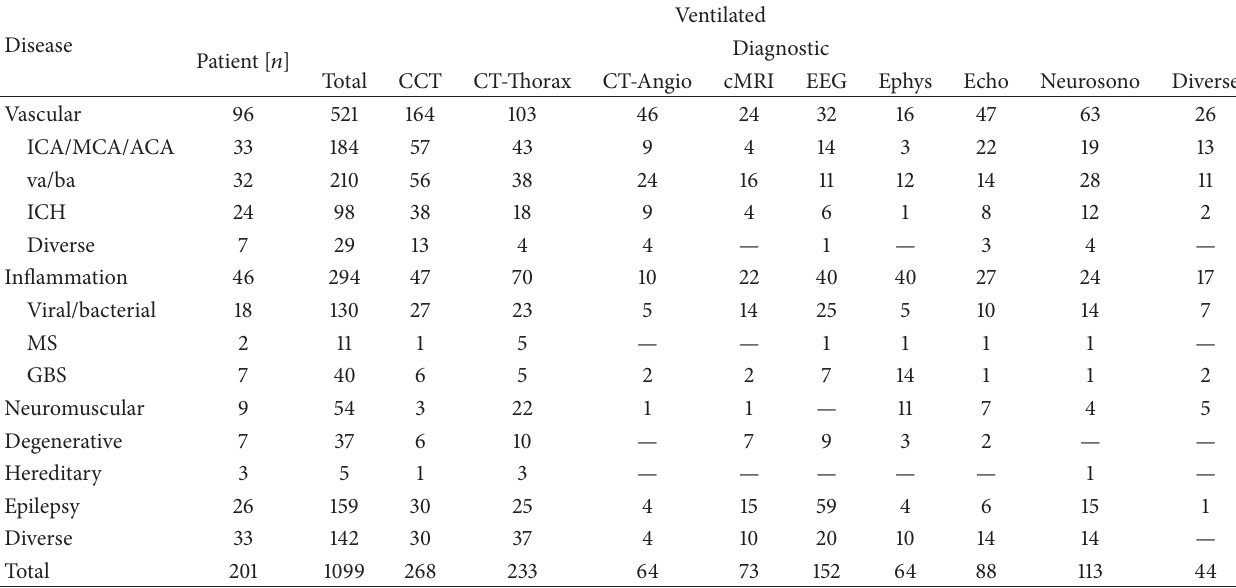
Table 3: Diagnostic procedures in ventilated patient